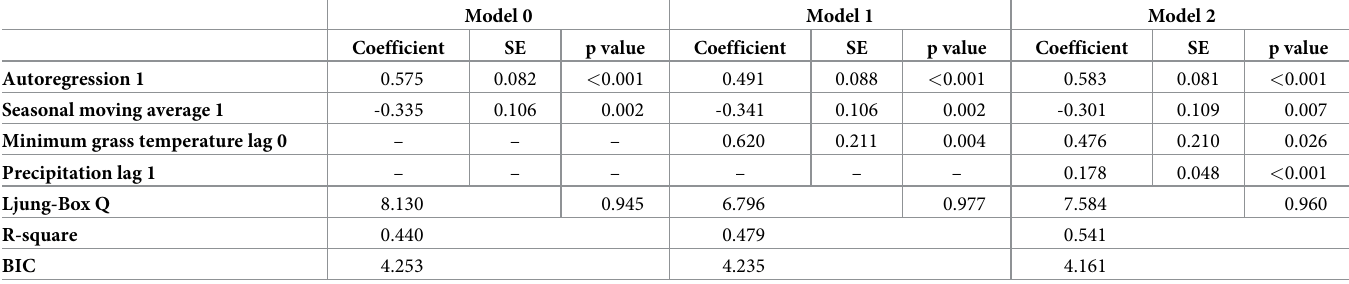
Table 4. Multivariate seasonal ARIMA models for Anopheles sinensis average abundance and climate factors in Goyang, Korea,